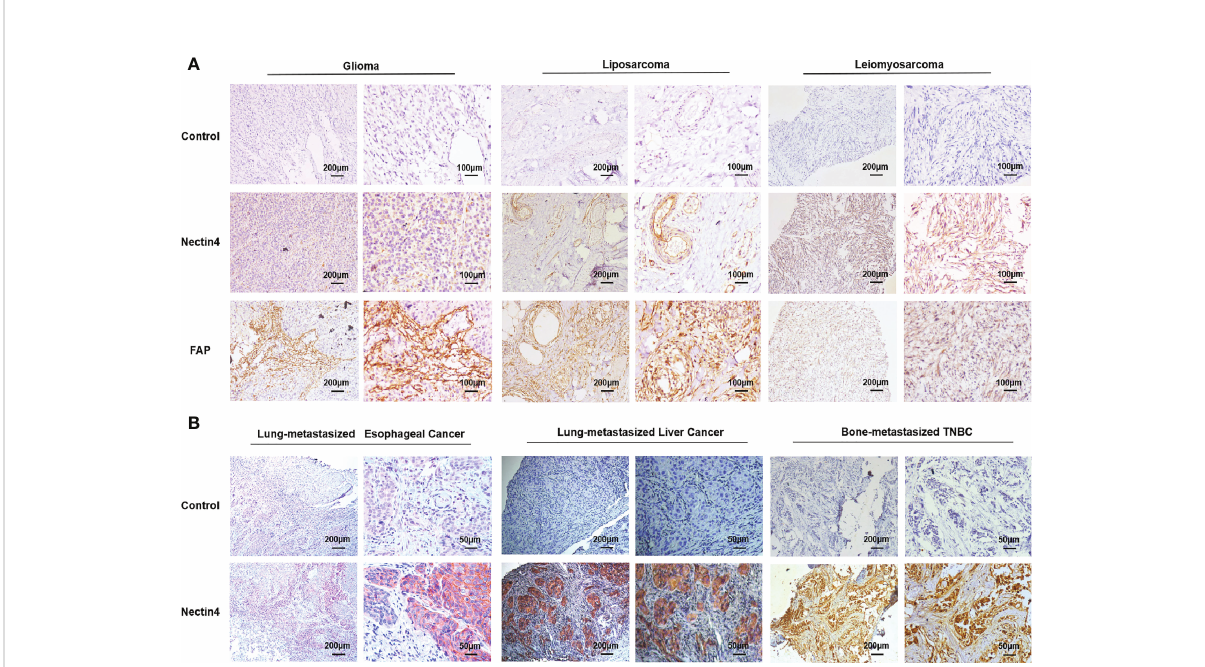
FIGURE 1 High expression of Nectin4 and FAP in a variety of cancers. (A) Expression of Nectin4 and FAP in glioma, liposarcoma, and leiomyosarcoma was assessed by IHC. (B) Expression of Nectin4 on lung-metastasized esophageal cancer, lung-metastasized liver cancer, and bone-metastasized triple-negative breast cancer (TNBC). Also see Supplementary Figure 3. Nectin4 is mainly located in the membrane (strongly positive) and cytoplasm (weakly positive) of cancer cells; FAP is mainly located in the membrane (strongly positive) and cytoplasm (weakly positive) of stromal cells, shown in